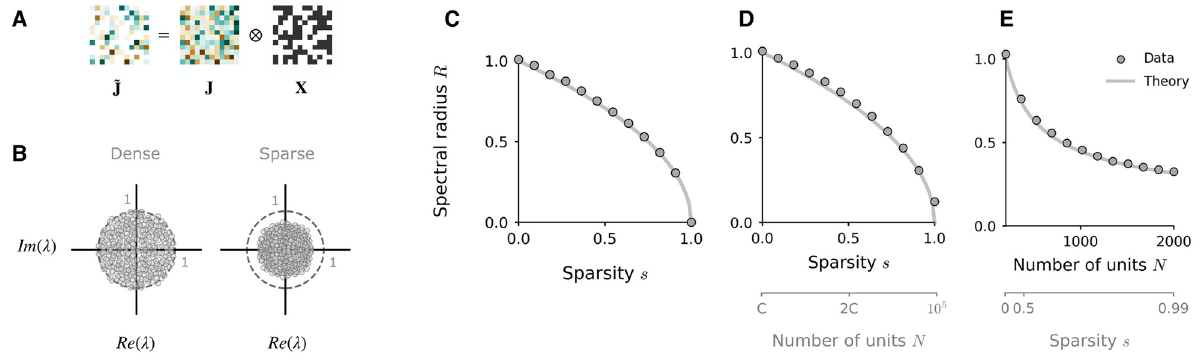
Fig 1. Influence of sparsity on the eigenspectra of full-rank networks. A : Illustration of how sparsity is imposed in the connectivity matrix, where the degree of sparsity is s = 0.5. B : Complex eigenspectra of full-rank, Gaussian connectivity matrices of finite size ( N = 300, g = 1) in the dense case (left) and with a sparsity of 0.5 (right). The dashed line plots the unit circle. C, D, E : Reduction of spectral radius R as a function of sparsity in a full- rank matrix J constructed as in (Eq 2) with connection strength g = 1. In C , sparsity is imposed as a fraction of total connections removed ( N = 1000). In D and E sparsity is imposed by fixing the number of outgoing connections to C = 200 and increasing N . Dots: mean empirical spectral radius, measured as the largest absolute value of all eigenvalues, over 50 instances. Solid lines: theoretical prediction (Eq (6)).